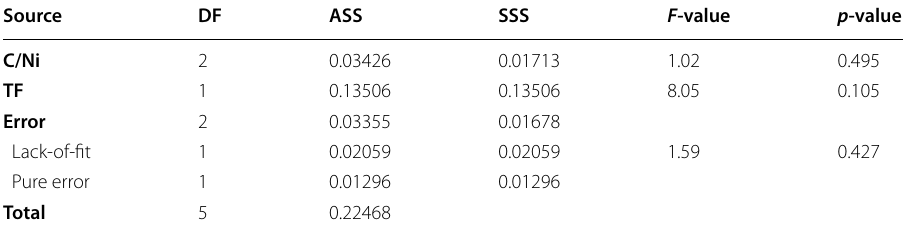
Table 6 ANOVA test associated with C/Ni and TF effects on TNK Source DF ASS SSS TF